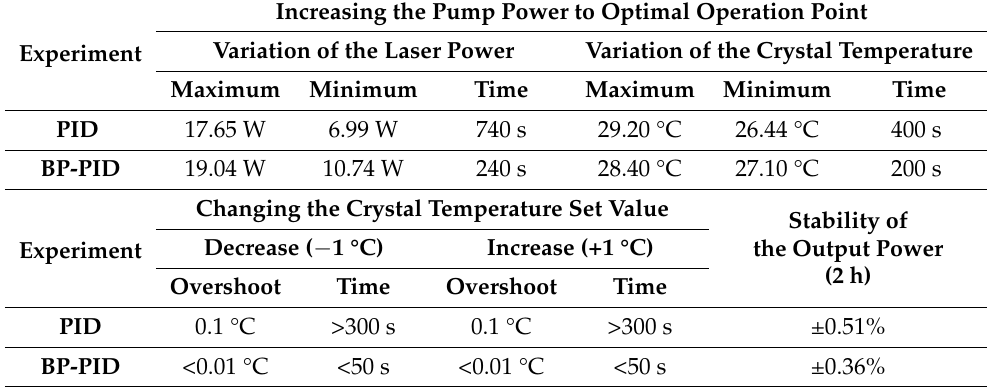
Table 1. Comparison of the experimental results between traditional PID and